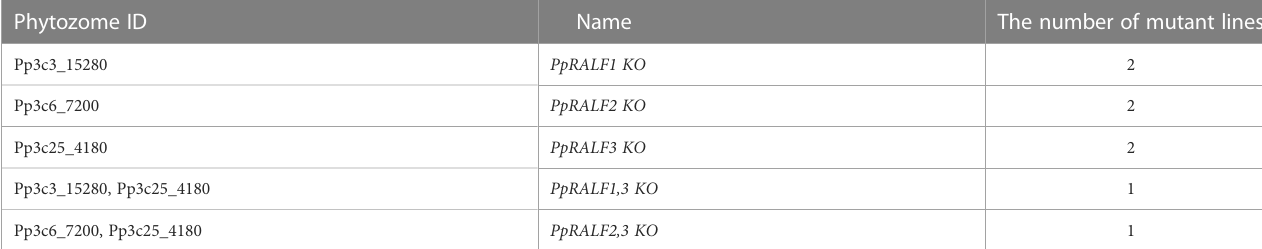
TABLE 1 The list of obtained mutant